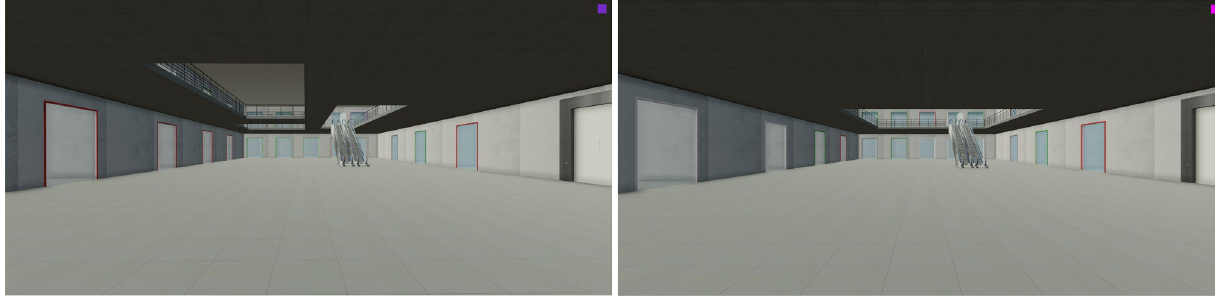
Figure 7. Exemplary screenshots from the desktop VR study (captured from the Unity3D 52 game engine) showing a first-person perspective taken from the entrance (starting point) for each of the two atria-types. The overall area of the second floor in each group was the same for both the distributed and centralized atria (i.e., 2 288 m ). Software used to create this figure: Unity3D 52 (version 2018.4.16f1), https:// unity 3d. com/ unity/ whats- new/ 2018.4. corrected-to-normal vision and the ability to discriminate colors (i.e., colorblind individuals were excluded). All participants completed an informed consent form before the study. Participants required, on average, 20.14 min payment = 30CHF), depending on their performance.